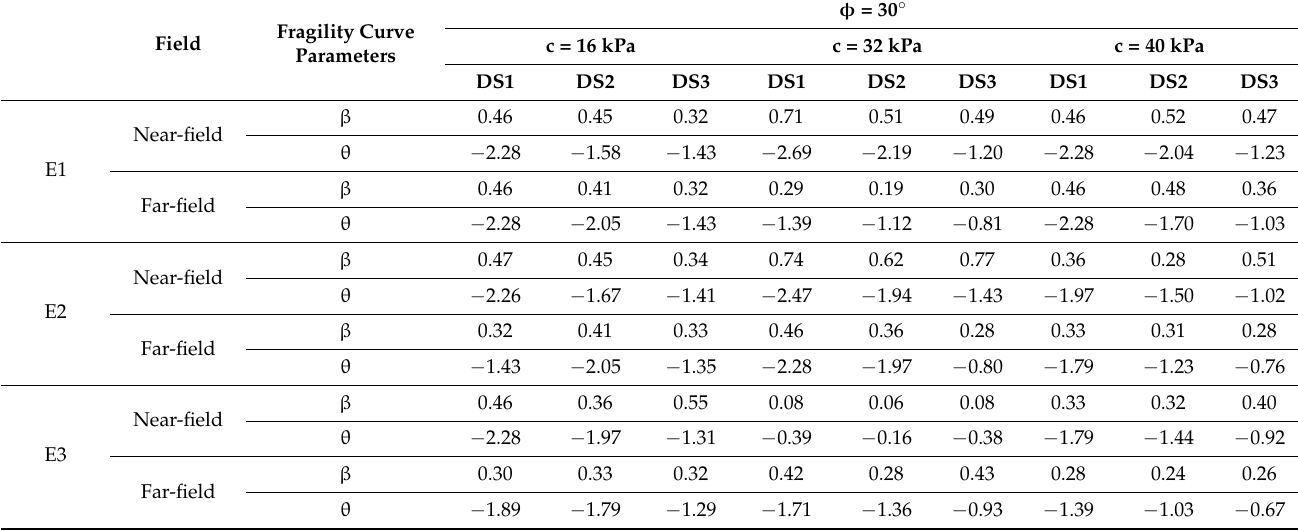
Table 8. Fragility curve parameters considering the different cohesion of the soil properties subjected to near-field and far-field earthquake ground